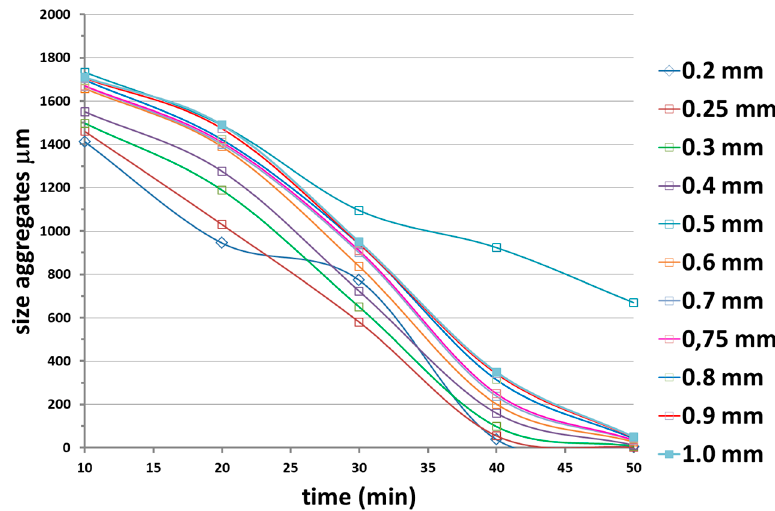
Figure 12. Evolution of the size aggregates with the time of application at different distances between the rollers.